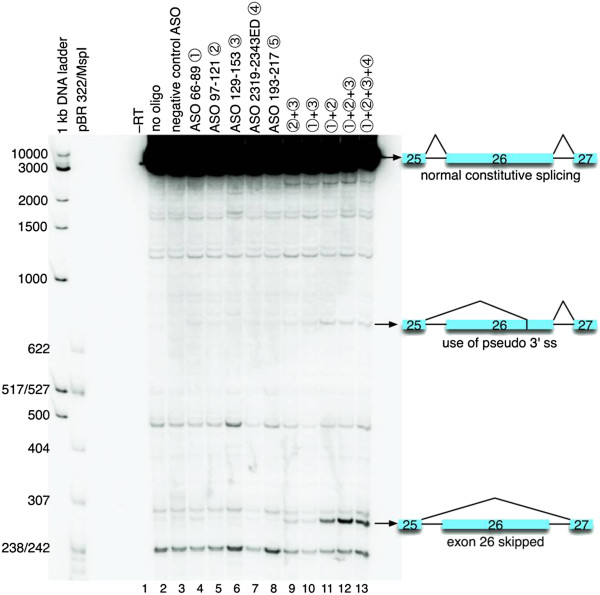
Microarchitecture of ESS activity in exon 26 sequences derived from fragment 1. (A) In vitro splicing assay of DNA ligase III C-ß splicing reporter, tagged with 25-mers derived from fragment 1 (1 hour splicing at 30°C). 10% PAGE shown. Lanes Cß = DNA ligase III C-ß construct without ESS; Cß ex27 1–25 = Cß + nt 1–25 of exon 27; Cß REP = Cß + native ESS; Cß IGF-I ex3 1–25 = Cß + nt 1–25 of exon 3 from IGF-I; DL3 Cß ex 26 lanes = nts of exon 26 shown. Adjacent cartoons show identity of bands. (B) Quantification of splicing efficiency, normalised to DNA ligase III C-ß reporter. Bars show splicing efficiency from n=4 experiments with DNA ligase III C-ß = 100%. Error bars show S.E.M. Overall one-way ANOVA shows p <0.0001. Comparison to DNA ligase III C-ß for each construct by Bonferroni’s multiple comparison test: statistically significant differences from efficiency of DNA ligase III C-ß splicing shown by *= p <0.01, **= p <0.001.